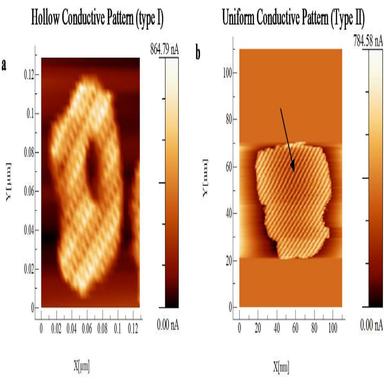
(a) Top view SEM image of gold nanorod sample (b) the top view of nanorods in higher magnification to illustrate the different contrasts between the nanorods' edge and centre.